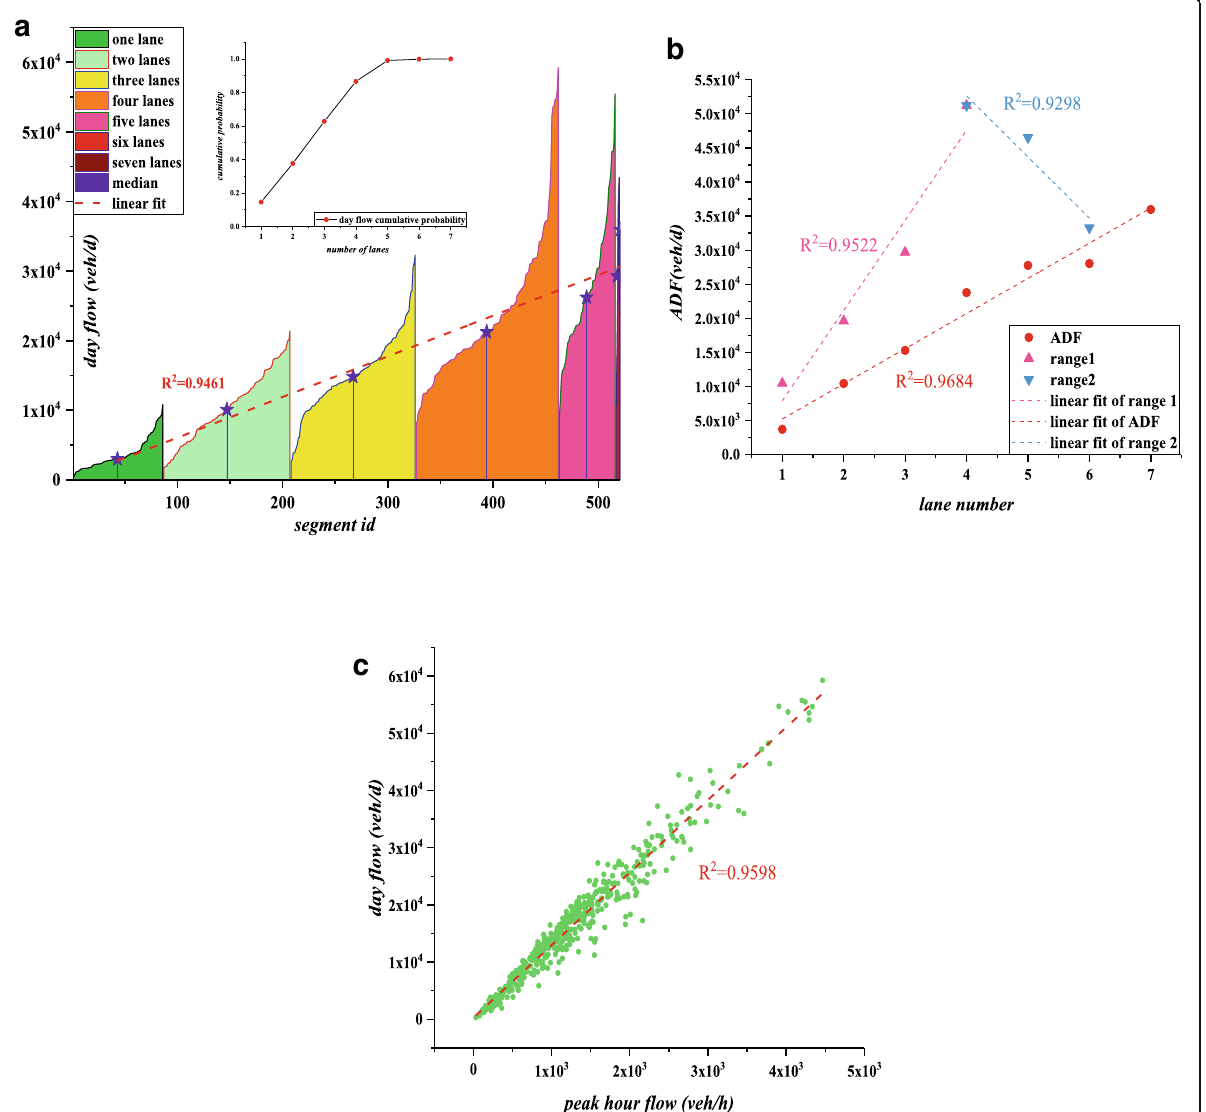
Fig. 8 Correlation between day flow and lane number: ( a ) daily total flow of segments with different lanes, and subgraph is day flow cumulative probability with increasing number of lanes; ( b ) average daily flow and range (max-min); ( c ) peak hour flow and day flow of